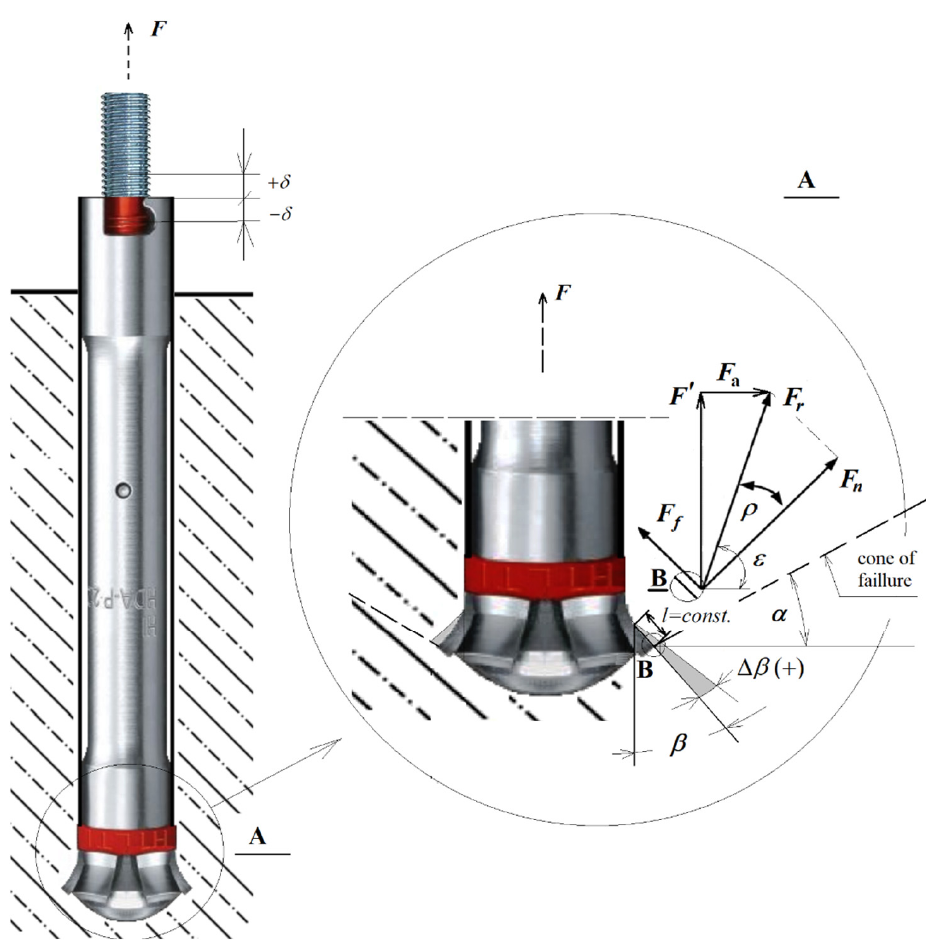
Figure 3. Force distribution on the undercutting element of the anchor: F —anchor pull-out force, F ’—a component of the anchor pull-out force per undercutting element, F f —friction force of anchor element against the rock, F n —normal component to the surface of the undercutting element, F a — circumferential component, F r —resultant force of the action of the undercutting element on the rock, ρ —the angle of friction of the rock against the undercutting element, ε —the angle of the resultant force F r , α —the angle of the pseudo-cone of failure, β —the angle of rock cut with the undercutting head element equal to the angle of the cone of the undercutting head (more precisely, the angle of half the head cone), ε —angle of the resultant force on a single undercutting element ( ε = β + ρ ), δ ( ± )—deviation of the marker’s position from the recommended nominal position affecting the change of the undercutting head angle ∆ β , and l = const.—length of the head